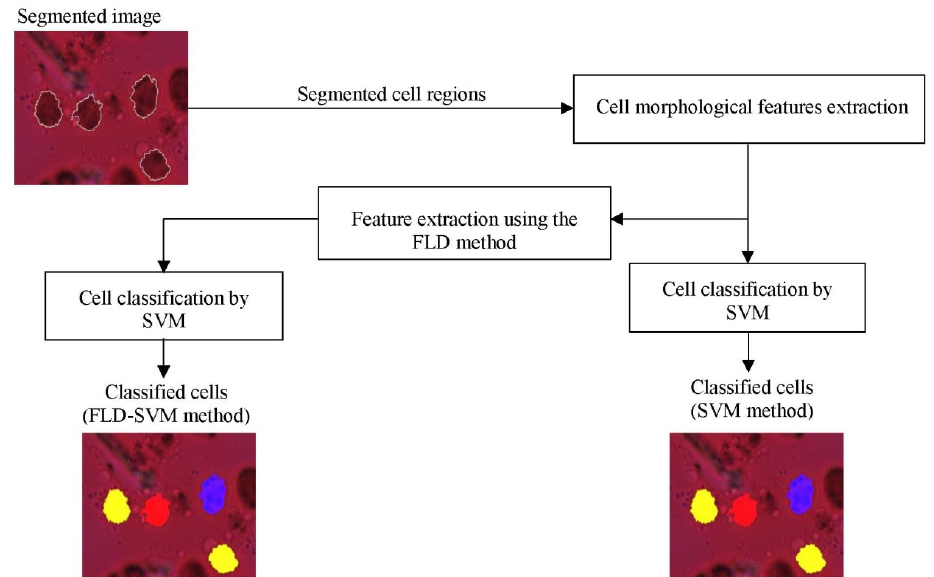
Figure 3. Examples of the classification results of dendritic cells by the SVM classifier with (FLD-SVM) and without (SVM) dimensionality reduction. The classified cells are marked by the following color masks: immature cell (yellow), mature cell (red), and inhibited cell (blue).